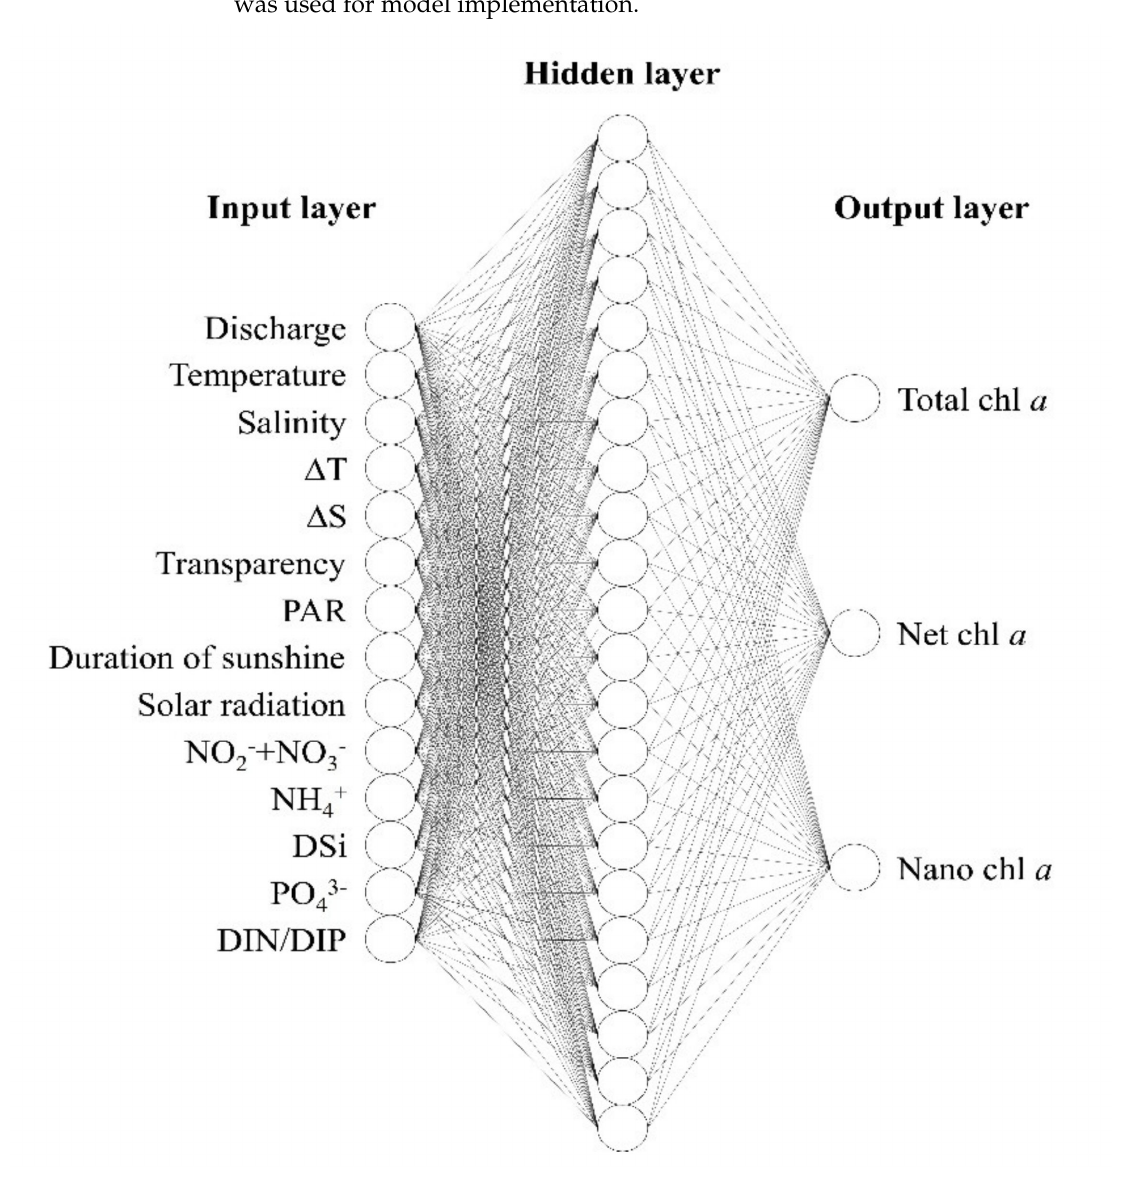
Figure 2. Structure of the artificial neural network